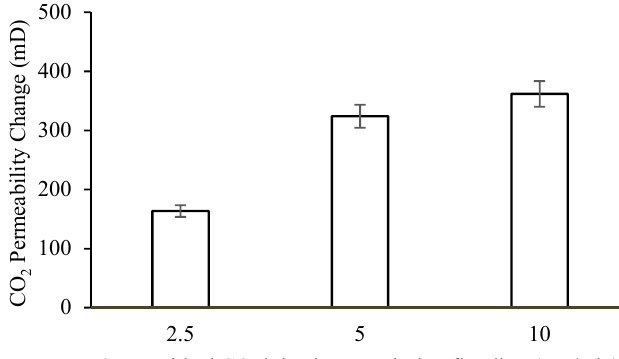
Figure 6. The impact of CO 2 injection flow rate on permeability after salt precipitation. Permeability change is the difference between the core permeability after salt precipitation before drag test and the permeability after drag test.